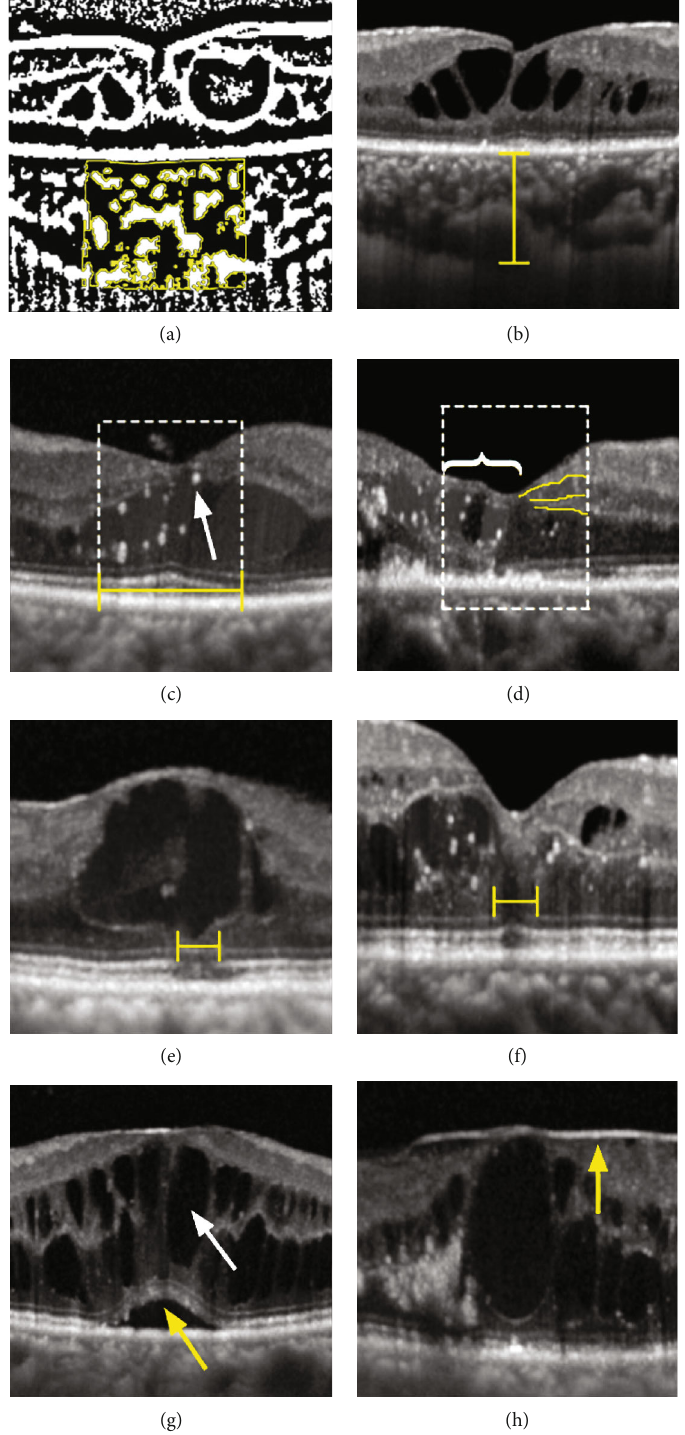
Figure 1: The morphological features evaluated in optical coherence tomography: (a) choroidal vascularity index (CVI); (b) subfoveal choroidal thickness (SFCT); (c) adjusted ellipsoid zone and external limiting membrane re fl ectivity; hyperre fl ective foci (HRF) (white arrow); (d) disorganization of the retinal inner layers (DRIL); (e) disruption of the ellipsoid zone; (f) disruption of the external limiting membrane; (g) the presence of subretinal fl uid (SRF) (yellow arrow) and cystoid abnormalities (white arrow); (h) presence of an epiretinal